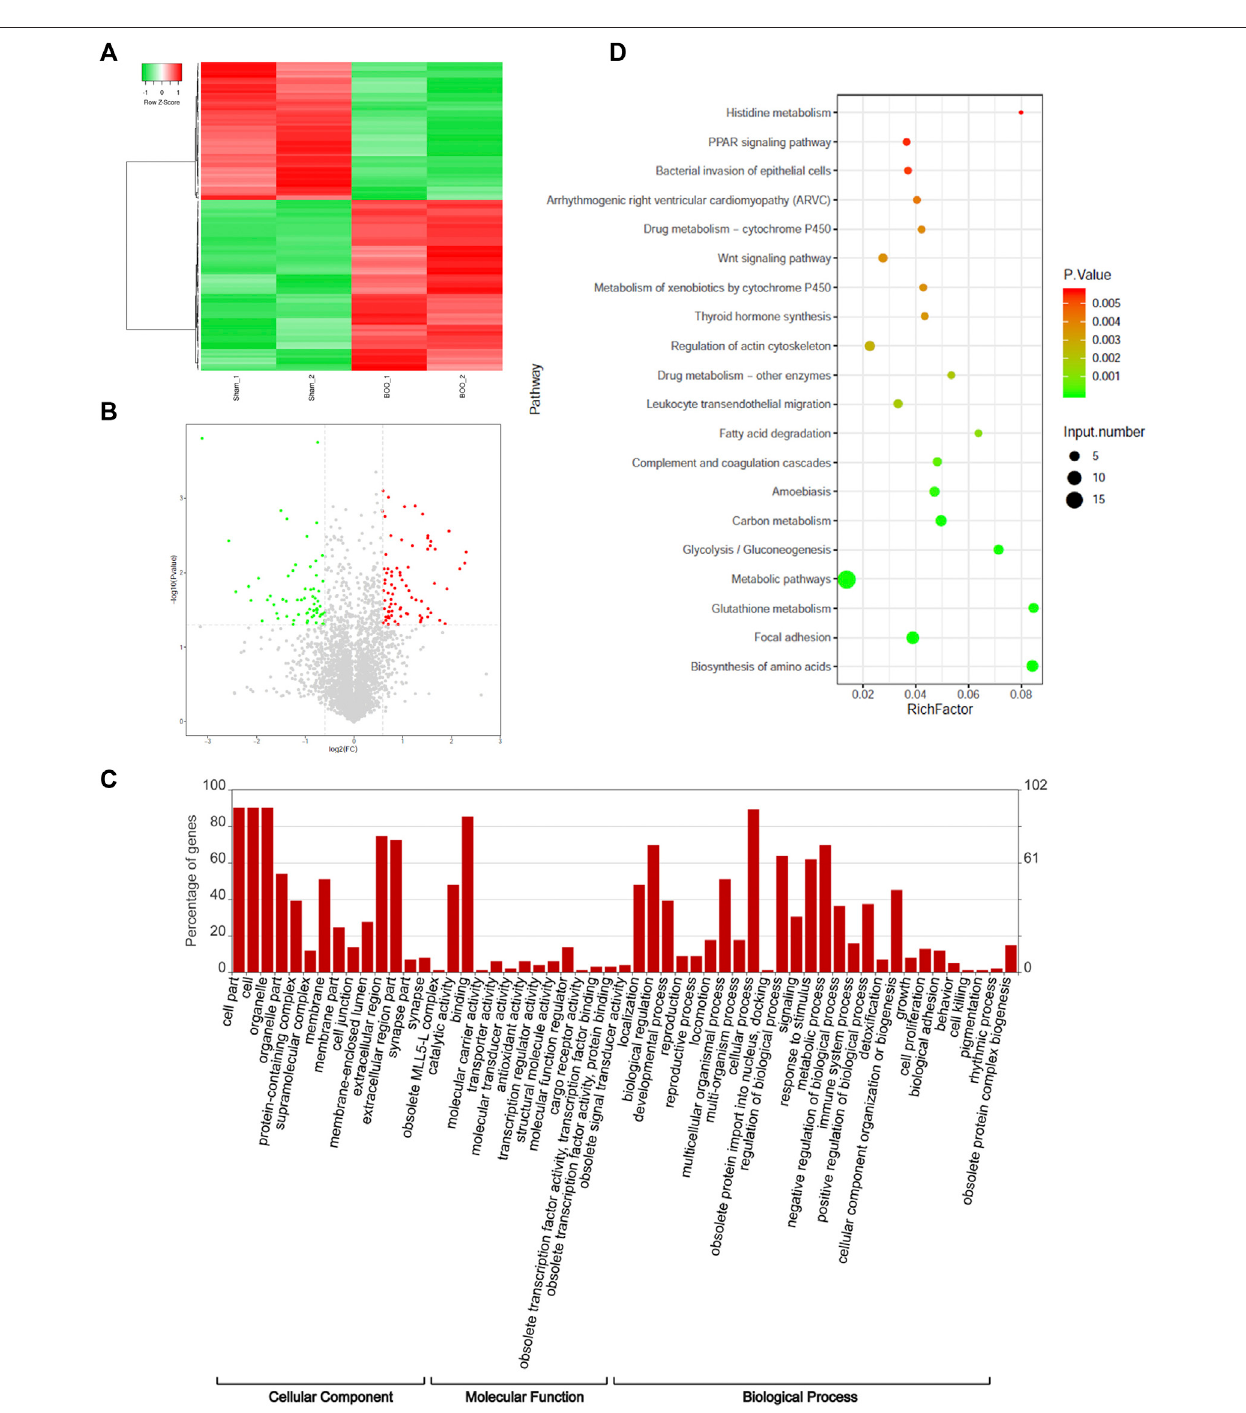
FIGURE 2 | Proteomic identi fi cation of differentially expressed proteins in rat BOO model. (A) Hierarchical clustering of proteins differentially expressed in the bladder tissues of rat BOO model. Elevation and decreases of protein expression compared with the Sham group were present as red and green lines respectively. (B) ThevolcanoplotdisplayingdifferentiallyexpressedproteinsinthebladdertissuesoftheratBOOmodel.Redandgreenspotsindicateup-regulatedanddown-regulated proteins respectively. (C) Functional categorization of proteins differentially expressed in the bladder tissues of the BOO rats. The enrichments of differentially expressed proteins in GO cellular components, molecular functions and biological processes were performed separately. (D) Functional categorization of differentially expressed proteins in rat BOO model based on KEGG signaling pathways. The enrichment signi fi cances were indicated by spot colors and protein numbers were indicated by the spot diameters.